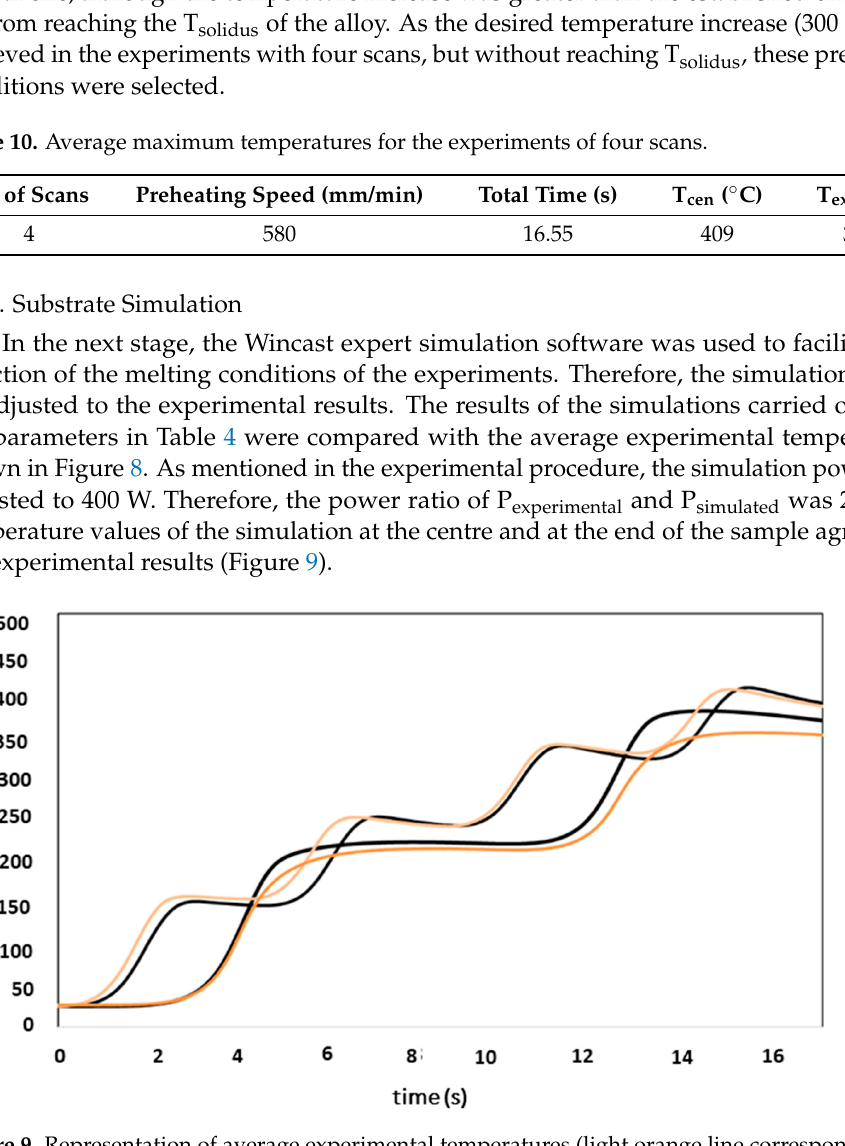
Figure 9. Representation of average experimental temperatures (light orange line corresponds to the centre and the other to the end) and simulated temperatures (black line) with WinCast expert.